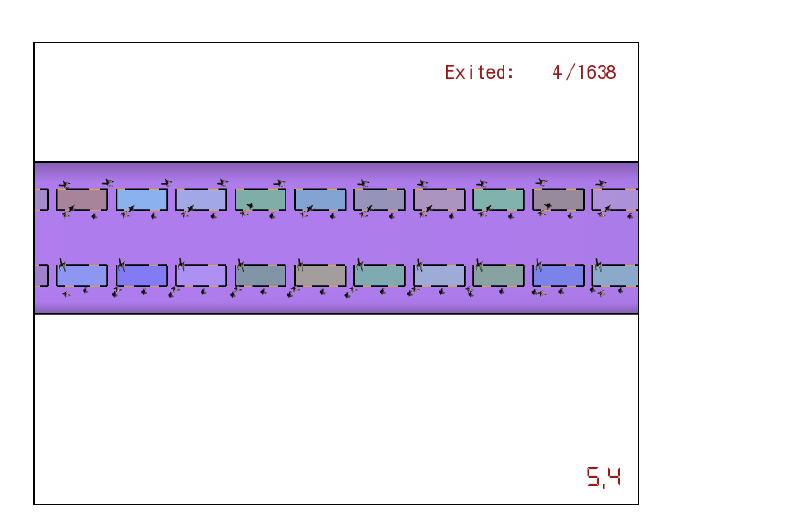
Figure 6 – The simulation example for the noted case after 5.4 seconds from the start of the